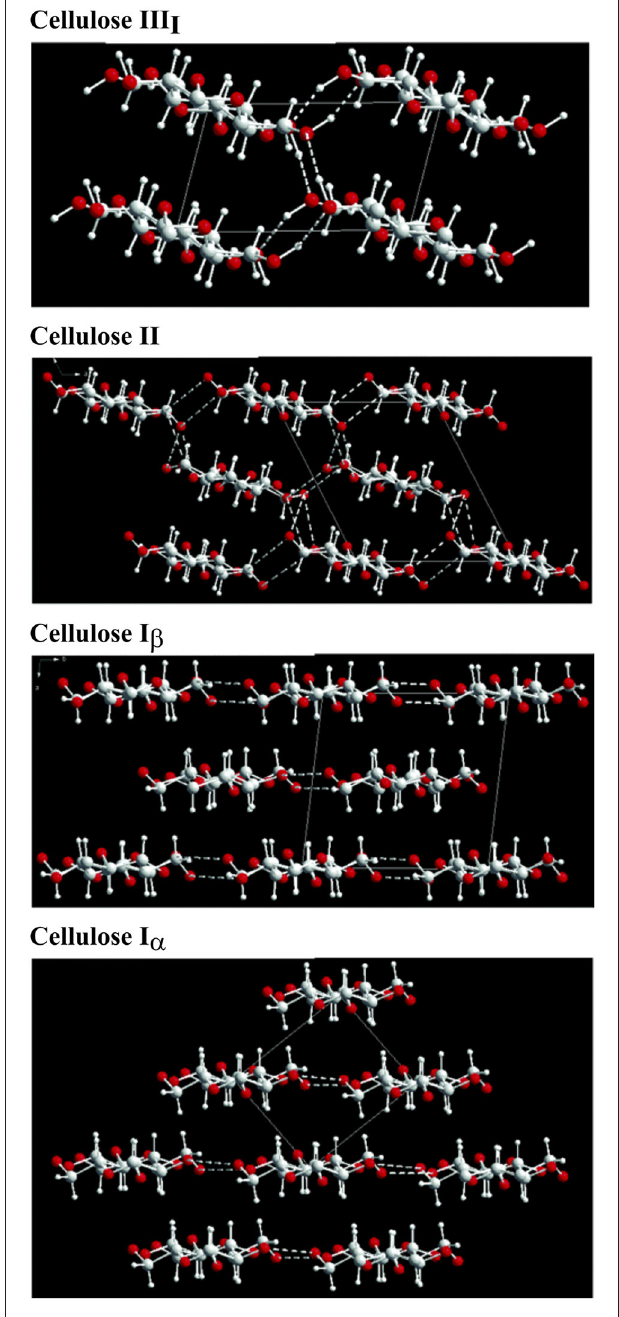
FIGURE 2 | Crystal structure cellulose strands and the corresponding major hydrogen bonding arrangements (Wada et al., 2004). Copyright 2004. Reproduced with permission from Elsevier